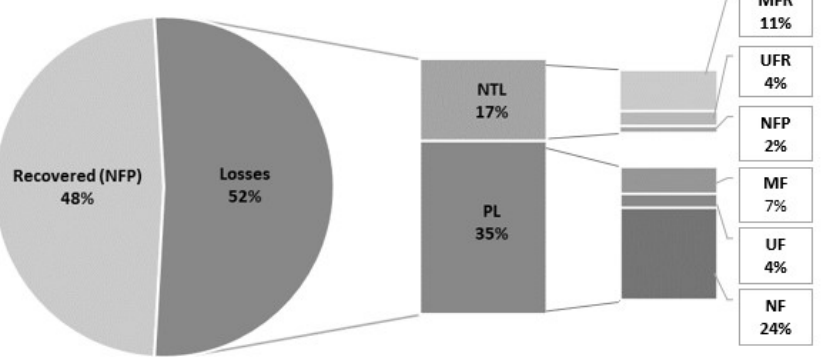
Figure 6. Mass balance of SH in the three-step filtration process as % of the feed. NTL: Non-target fraction losses (MFR, UFR, NFP); PL: processing losses (in MF, UF and NF) .